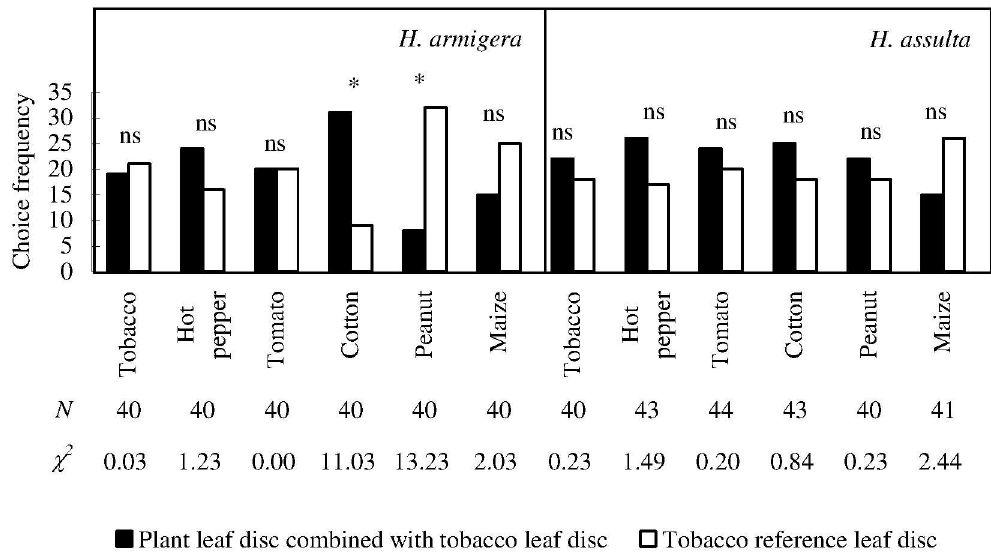
Fig 7. Choice responses of H . armigera and H . assulta newly hatched larvae under the conditions of each plant leaf disc combined with tobacco leaf disc versus tobacco leaf disc. “ * ” indicates significantdifference within group at P = 0.05 level, and “ns” indicatesno significantdifference within group, accordingto chi-squaretest. The values of “ N ” and “ χ 2 ” beneathrespectivebars indicatenumber of test insects and statistical χ 2 values, respectively.